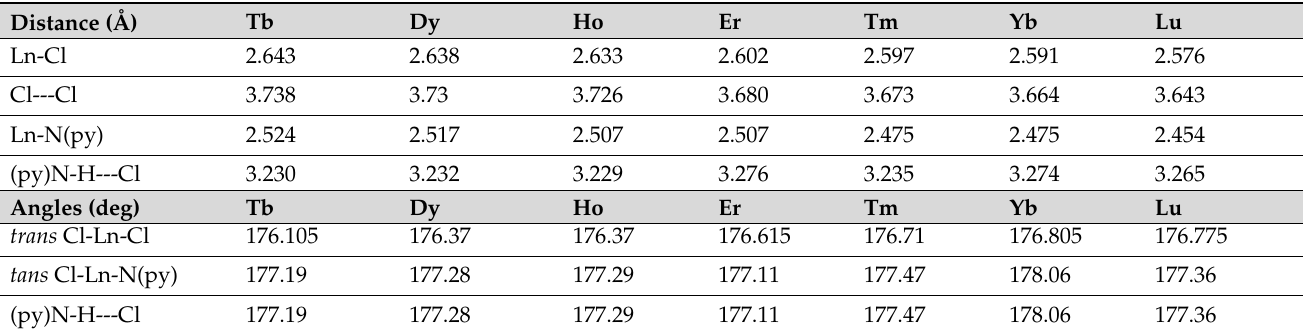
Table 3. Average, select, metrical data for Ln-5